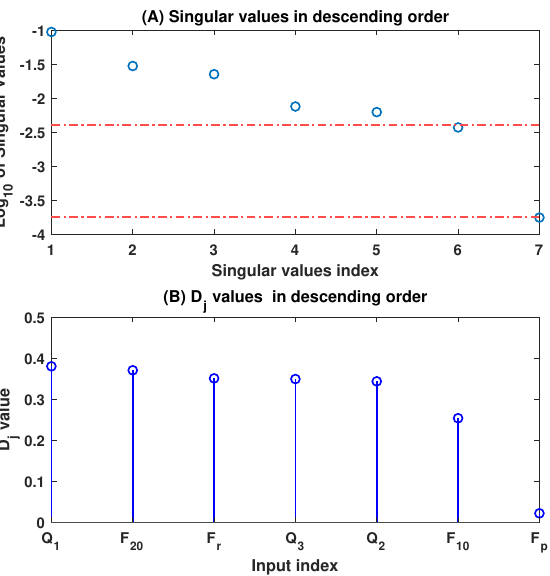
Figure 5. Singular values of S C and the D j values associated with the dominant singular values. Table 2. Elements of the reduced state and input vectors and the used measured outputs. State X B 3 T 1 T 2 X B 2 Output T 1 T 2 Input Q 1 F 20 F r Q 3 Q 2 F